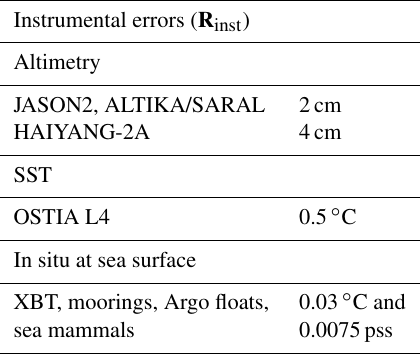
Table 1. Instrumental errors used for the current operational